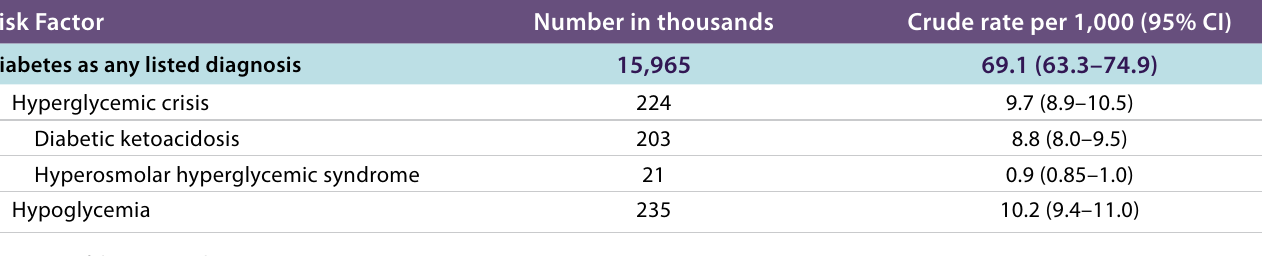
Table 5. Number and rate of emergency department visits per 1,000 adults aged 18 years or older with diabetes for selected causes, United States, 2016 Risk Factor Number in thousands Crude rate per 1,000 (95% CI) Diabetes as any listed diagnosis